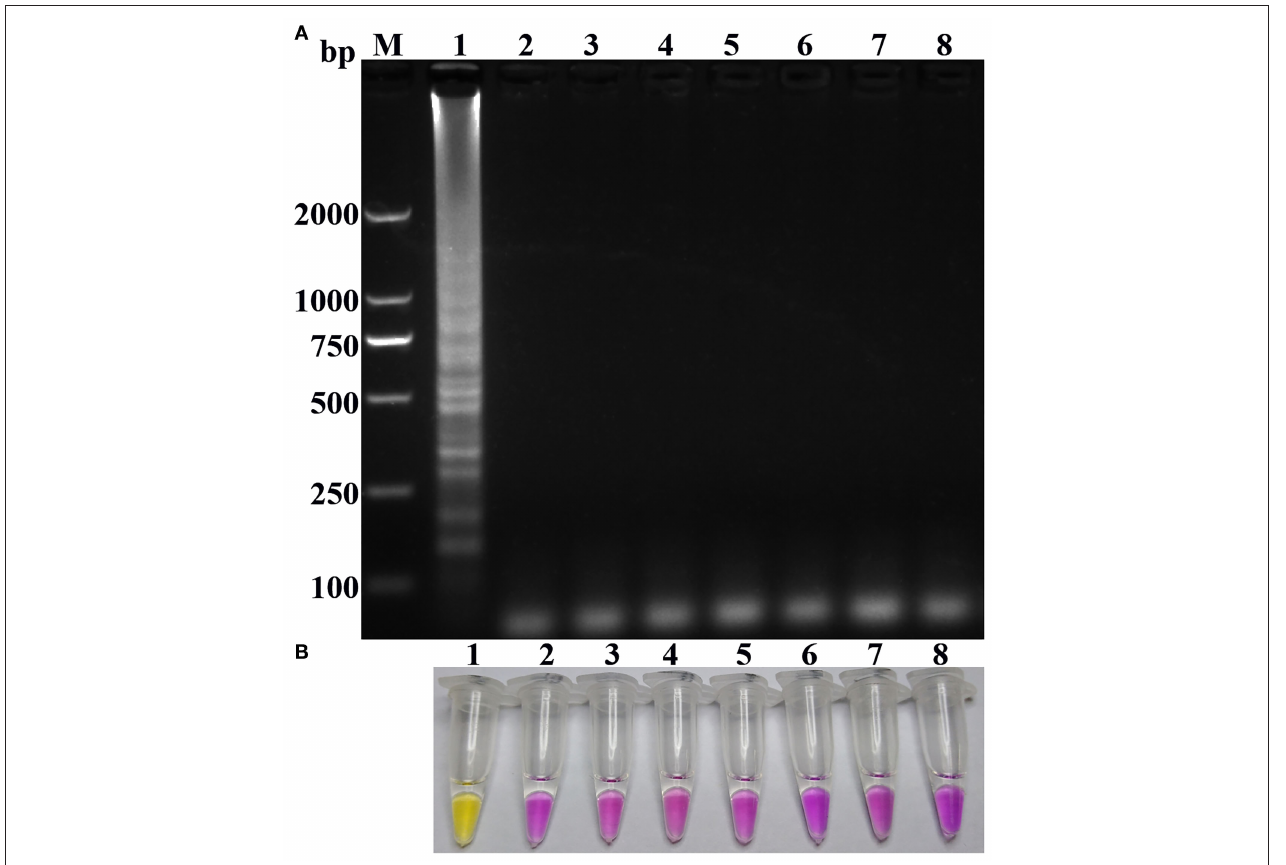
FIGURE 2 | Specificity of the one-step RT-PSR amplification for N-GoAstV: (A) Agarose gel electrophoresis of RT-PSR amplification products. (B) Visual detection of positive and negative PSR amplification products. Lane M, molecular size marker DL2000; Lane 1, N-GoAstV; Lane 2, GPV; Lane 3, GHPV; Lane 4, GREOV; Lane 5,